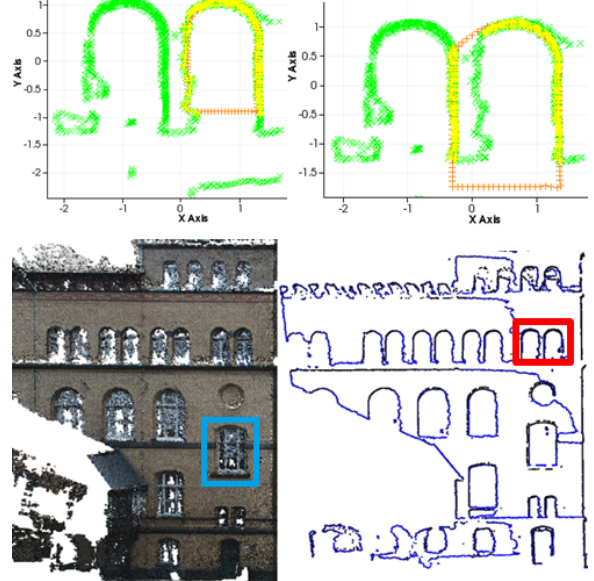
Figure 5: The bottom row shows on the left hand side the input 3D point clouds and the right hand a single element of {B ( i ) enlarged portion of the red marked area is shown on the top row. The green crosses are the boundary points, the brown pluses are 100 interpolation points of the B-spline curve used in fitting the data. The inliers of these curves are shown by the yellow